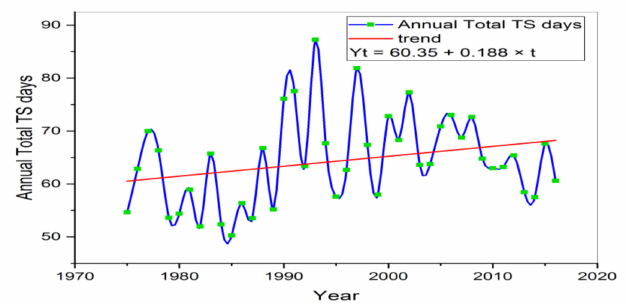
Figure 4. Same as Figure 3, but for annual